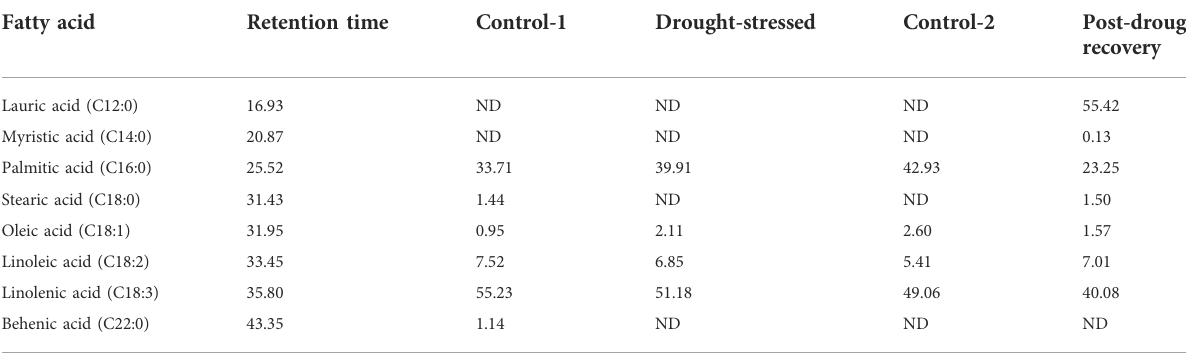
TABLE 1 Fatty acid percent composition in wheat samples at different stages.